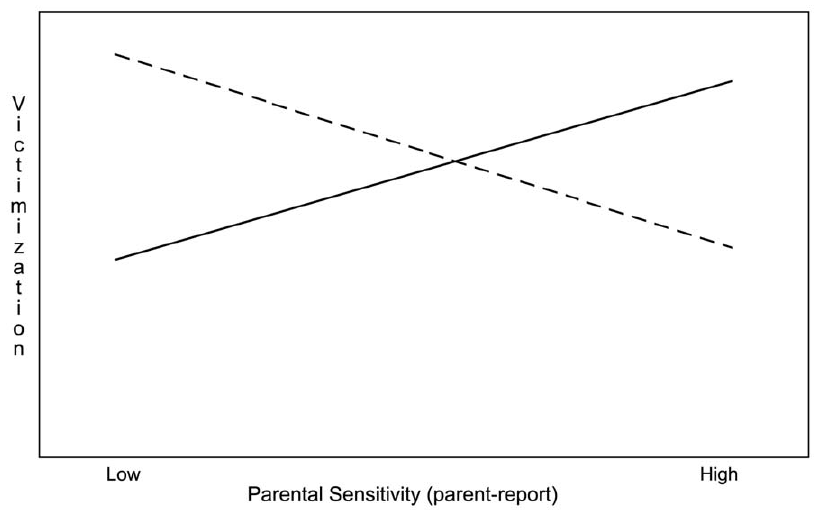
Figure 1. Associations between Parental Sensitivity PR and Victimization for DHH (dotted line) and Hearing Children separately.